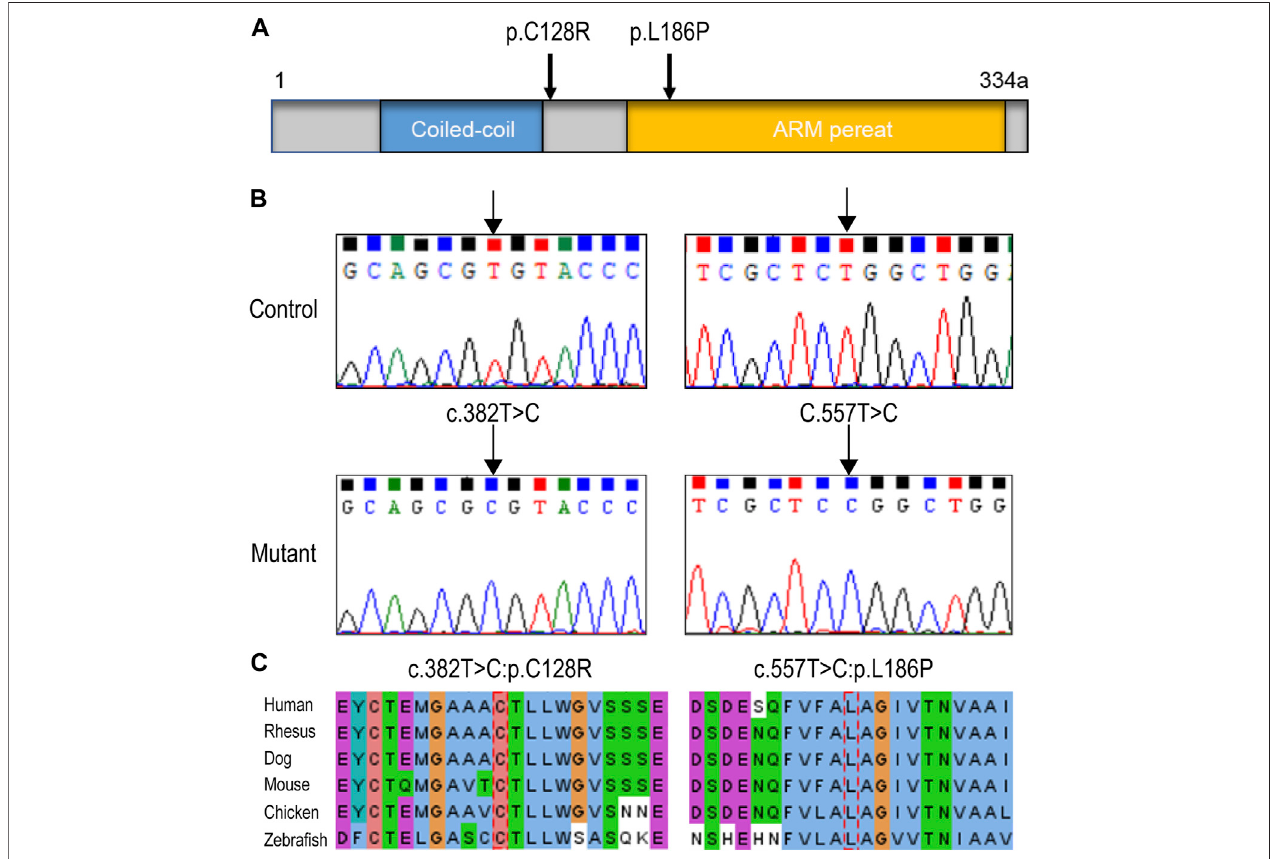
FIGURE 1 | HSF2BP variations identi fi ed in premature ovarian insuf fi ciency (POI) patients. (A) The structure of HSF2BP protein and the localization of the two variations. (B) The DNA sequence chromatograms of two variations identi fi ed in present study. (C) The amino acid sites of the two variations were highly conserved among